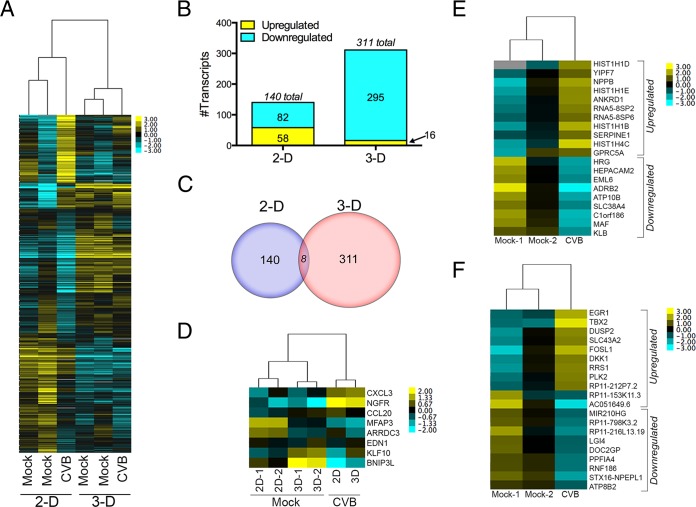
(A) Hierarchical clustering heat map of genes expressed in mock- or CVB-infected 2-D or 3-D cultures of Caco-2 cells as determined by RNA-Seq. The heat map shows the data from two independent mock-infected 2-D or 3-D cultures. (B) Number of differentially expressed genes from a single CVB-infected culture. The number of differentially expressed genes was determined by DESeq2 (P < 0.01) in 2-D or 3-D cultures of mock- versus CVB-infected cells. The number of upregulated transcripts is shown in yellow, and the number of downregulated transcripts is shown in blue. (C) Venn diagram of number of differentially expressed transcripts (as determined by DESeq2; P < 0.01) between 2-D and 3-D cultured Caco-2 cells. Only eight transcripts were shared between the two culture conditions. (D) Hierarchical clustering heat map of genes differentially expressed (P < 0.01) and shared between 2-D and 3-D cultures of CVB-infected Caco-2 cells as determined by RNA-Seq, followed by DeSeq2 analysis. (E) Hierarchical clustering heat map of genes differentially expressed (P < 0.01) specifically in CVB-infected 2-D cultures as determined by RNA-Seq, followed by DeSeq2 analysis. (F) Hierarchical clustering heat map of genes differentially expressed (P < 0.01) specifically in CVB-infected 3-D cultures as determined by RNA-Seq, followed by DeSeq2 analysis. In panel A and panels D to F, the intensity of the color indicates the level of gene expression (yellow for upregulation and blue for downregulation), and gray indicates that no RNA-Seq reads were detected for that transcript in that sample